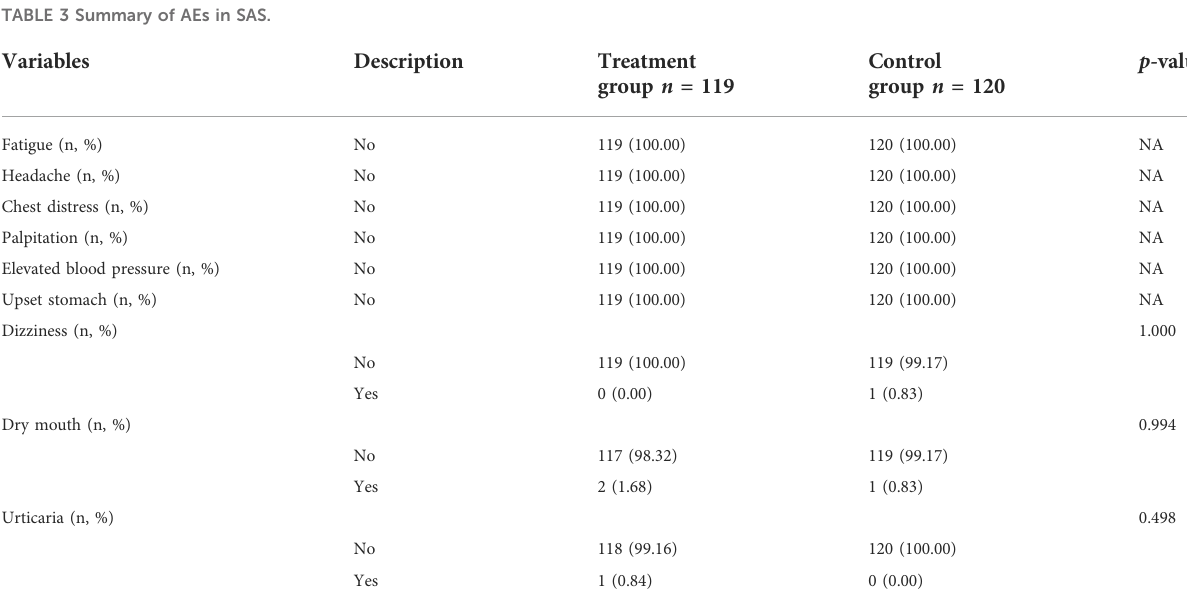
TABLE 3 Summary of AEs in